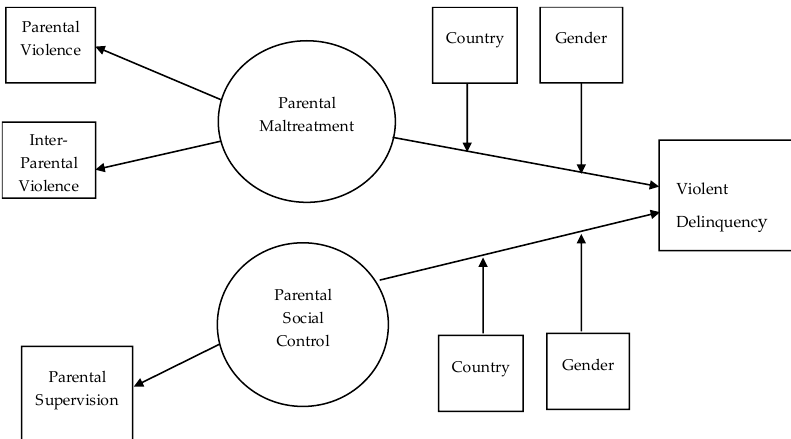
Figure 1. Theoretical Framework of Study. We conceptualized gender and country as modifying variables. We expect that gender and country would modify the associations between ( a ) parental maltreatment and self-reported violent delinquency and ( b ) parental social control and self-reported violent delinquency. Parental maltreatment includes both direct exposure to violence inflected by parents (i.e., parental violence) and indirect exposure to violence (i.e., inter-parental violence or violence between parents) whereas parental supervision was used to measure parental social